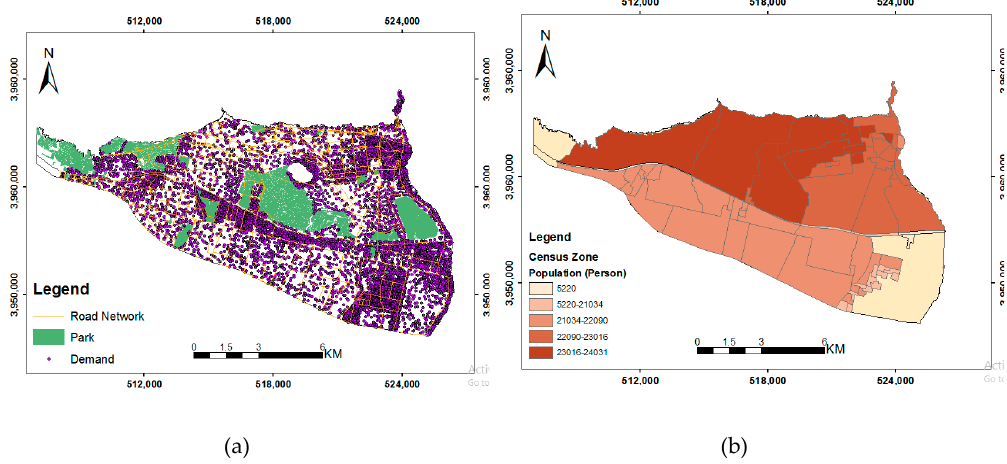
Figure 3. ( a , b ) Population demand in the 21st and 22nd districts of Tehran and population distribution in statistical zones.